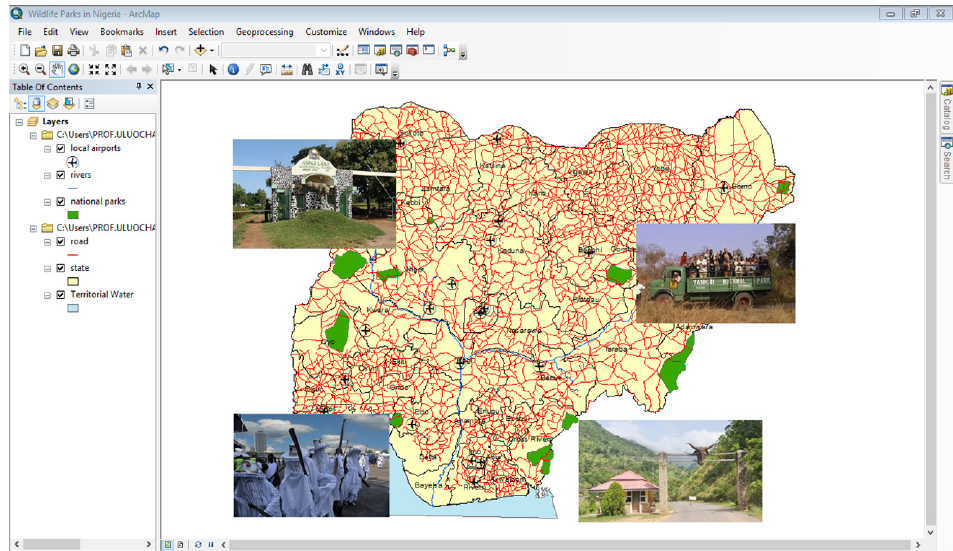
Fig. 4. Screenshot of a GIS tourist map of Nigeria hyperlinked with photos of some tourist